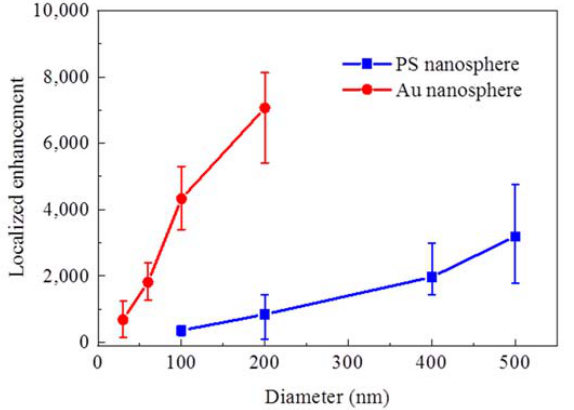
Figure 4. The diameter-dependent localized enhancement of single PS and Au nanospheres under TM illumination.